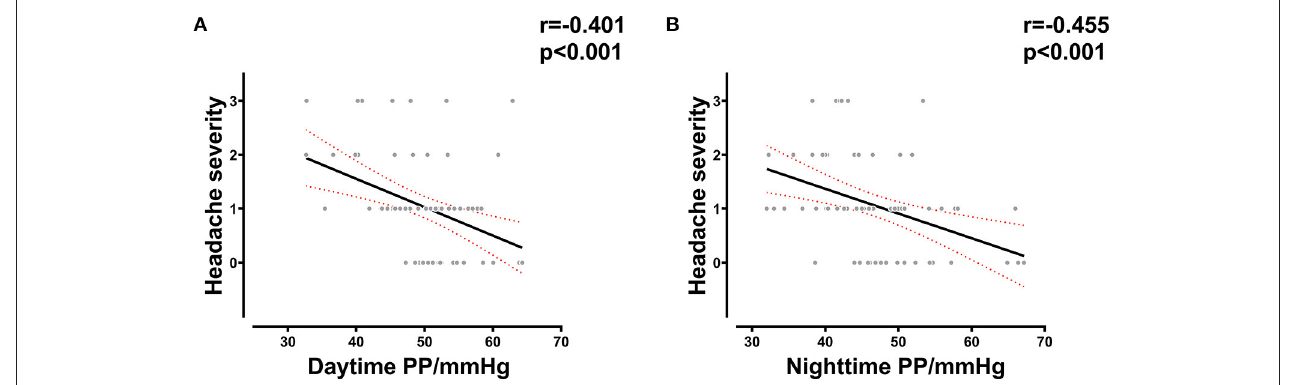
FIGURE 2 | Correlation between PP and AMS-related headache severity. (A) Correlation between daytime PP at LA and headache severity in all subjects. (B) Correlation between nighttime PP at LA and headache severity in all subjects. LA, low altitude; AMS, acute mountain sickness; PP, pulse